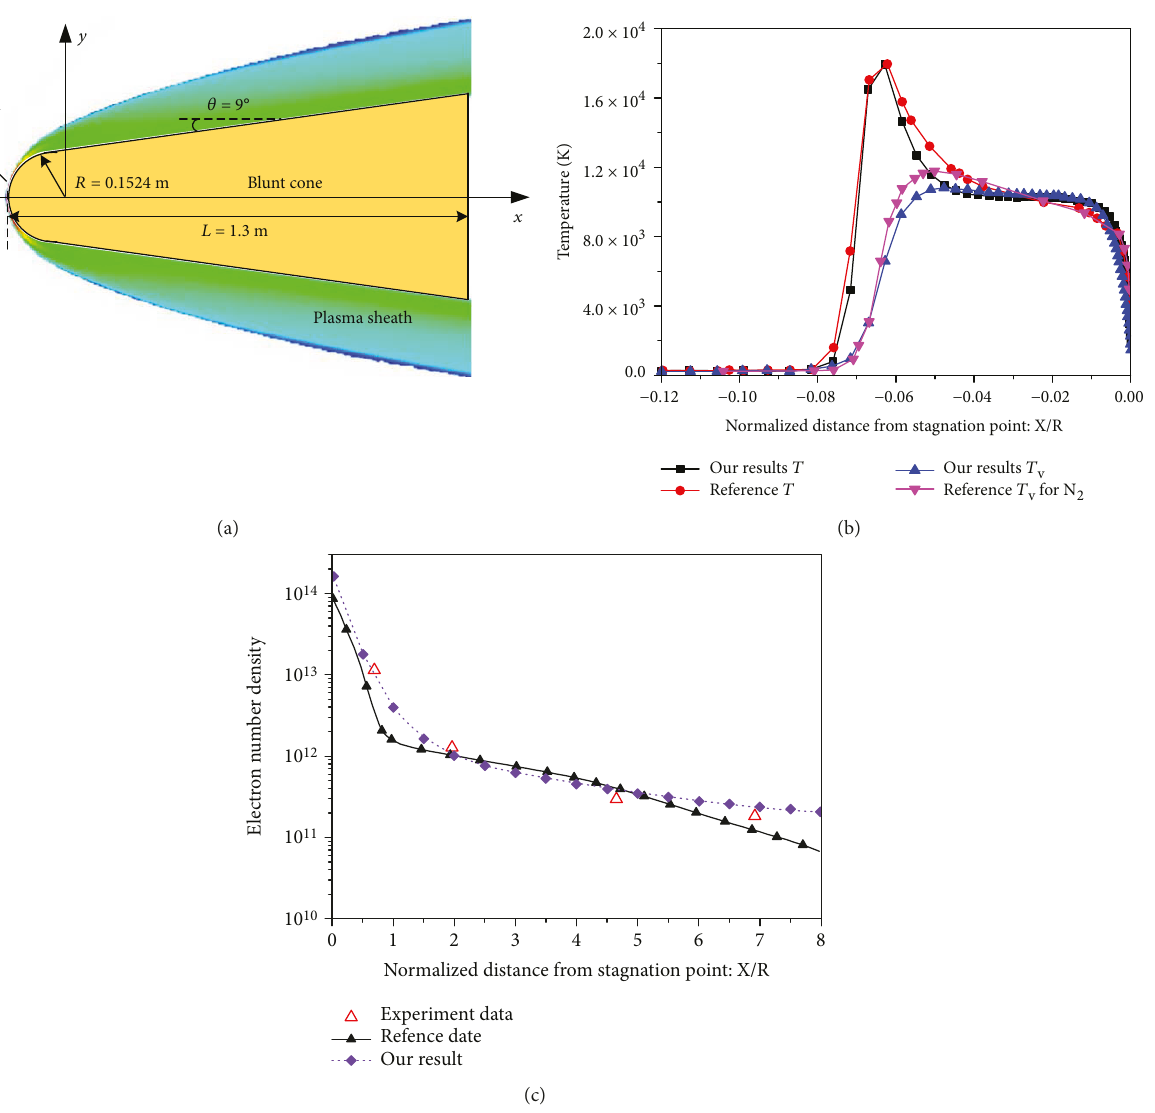
Figure 1: (a) Geometry of the RAM-C II vehicle enveloped by a plasma sheath. (b) Distributions of temperature along the stagnation line. Results given in [28] are cited for the purpose of comparison. (c) The peak of electron number density following the axial distance. Experimental data and simulation results given in [28] are cited for the purpose of comparison. The RAM-C II vehicle is assumed to be at 61km height with a velocity of